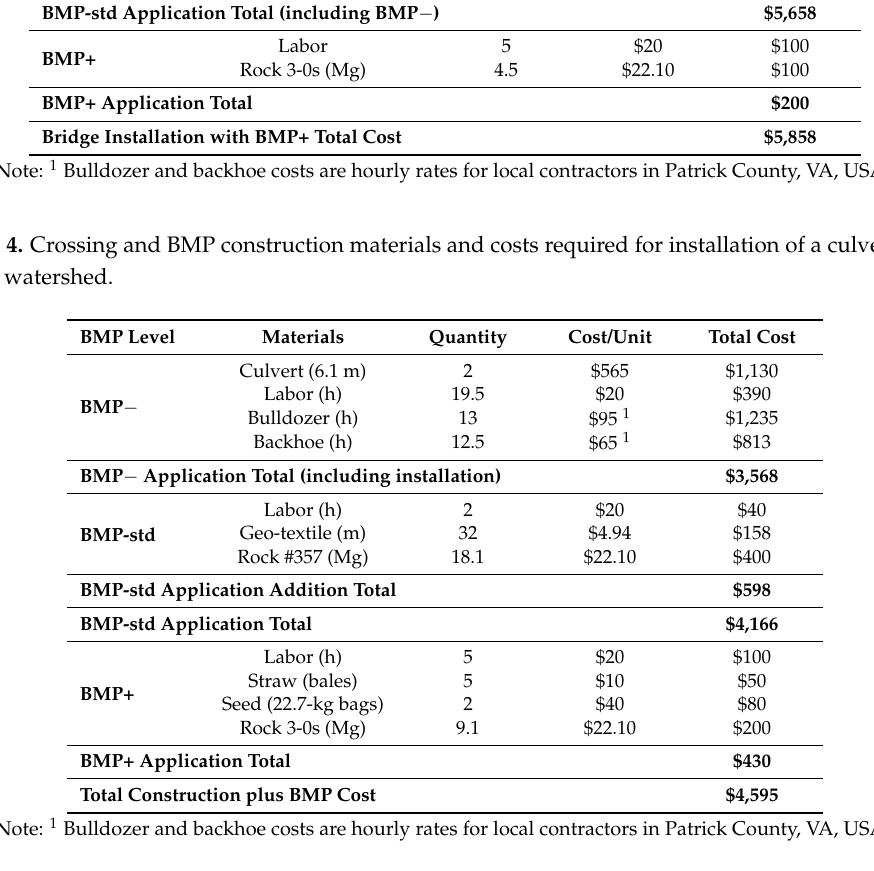
Table 5. Crossing materials and costs for construction of an improved ford stream crossing using